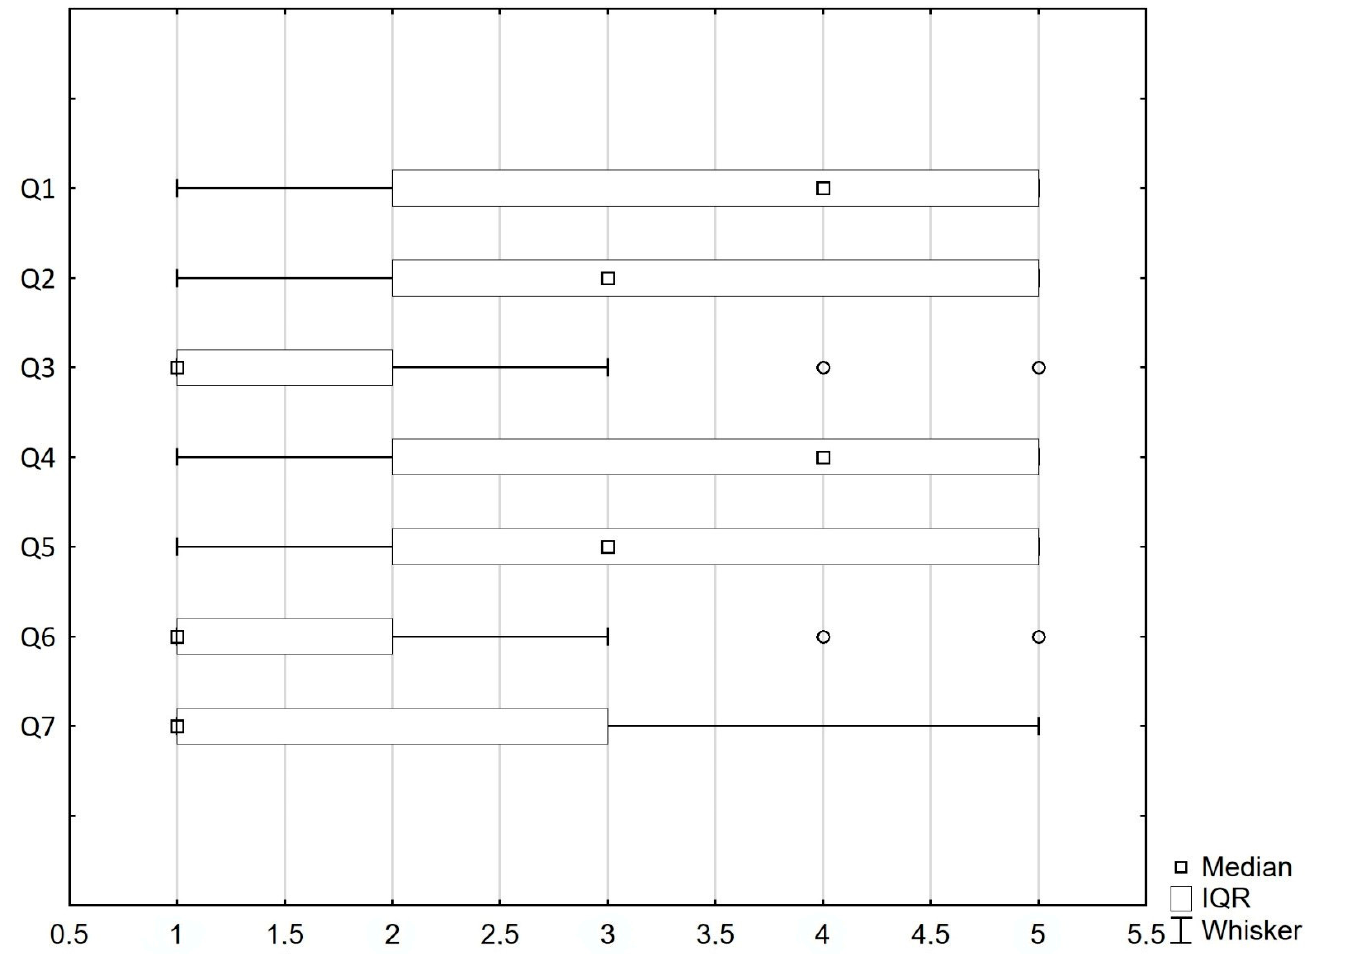
Figure 3. Fear of COVID-19 scale: Individual item results (Q1–Q7), median, IQR. Q1—I am most afraid of coronavirus-19; Q2—It makes me uncomfortable to think about coronavirus-19; Q3—My hands become clammy when I think about coronavirus-19; Q4—I am afraid of losing my life because of coronavirus-19; Q5—When viewing news and stories about coronavirus-19 on social media, I become nervous or anxious; Q6—I cannot sleep because I’m worried about getting coronavirus-19; Q7—My heart races or palpitates when I think about getting coronavirus-19. Point 1—I strongly disagree, point 5—I strongly agree.